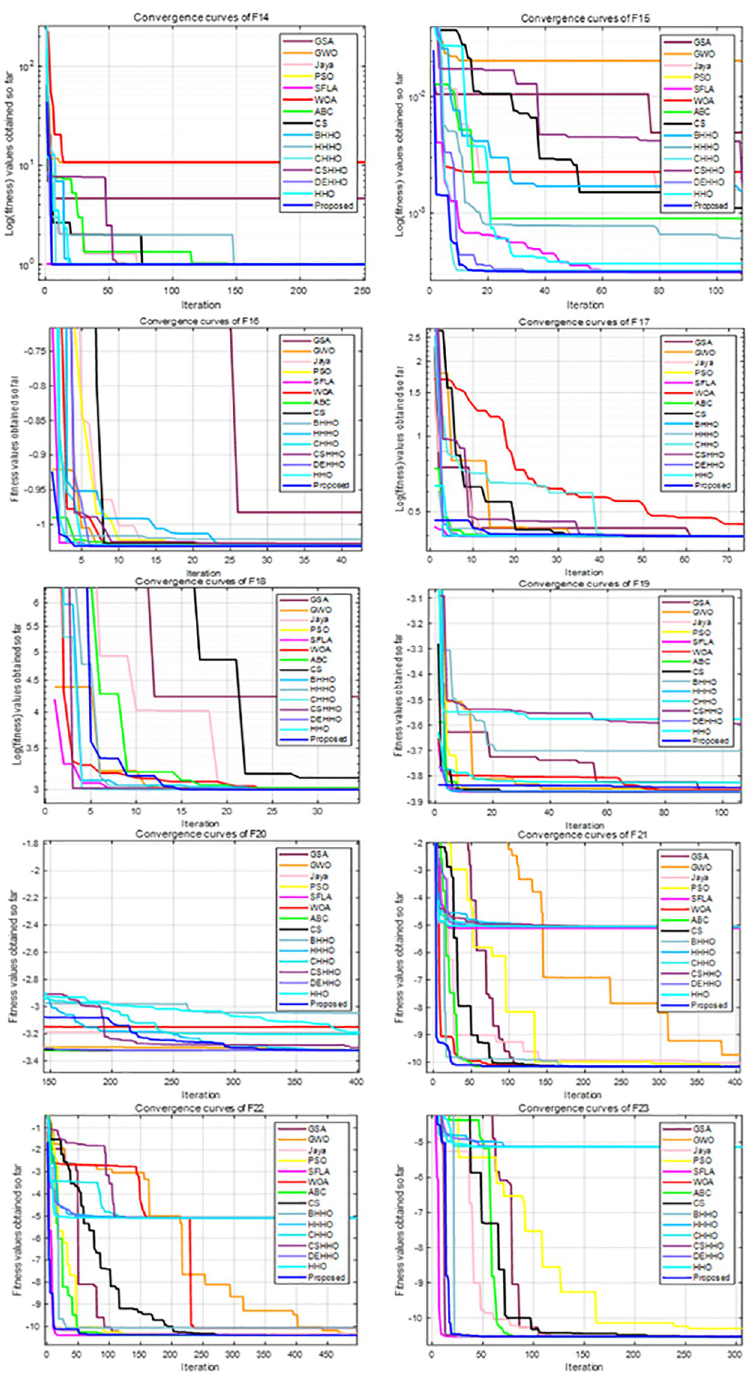
Fig 7. Convergence curves of